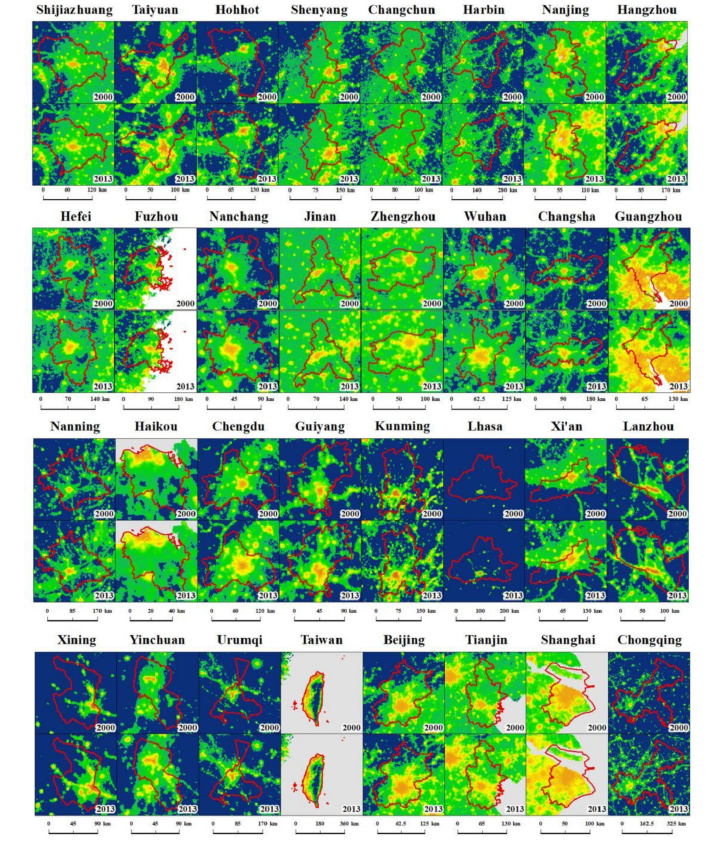
Figure 10. CCD of 28 provincial capital cities and 4 municipalities directly under the central govern- ment in 2000 and